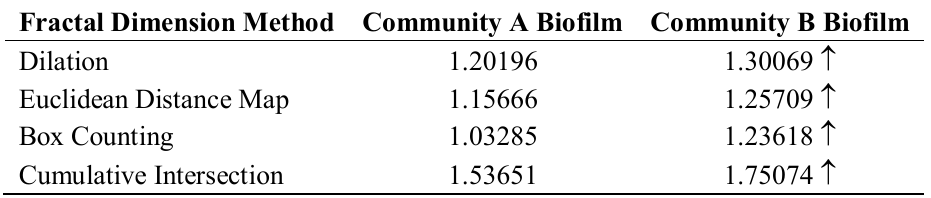
Table 5. Fractal geometry of the natural biofilm assemblages of microbial communities A and B developing on plain glass and polystyrene substrata, respectively. The higher values of fractal dimension are indicated by upward